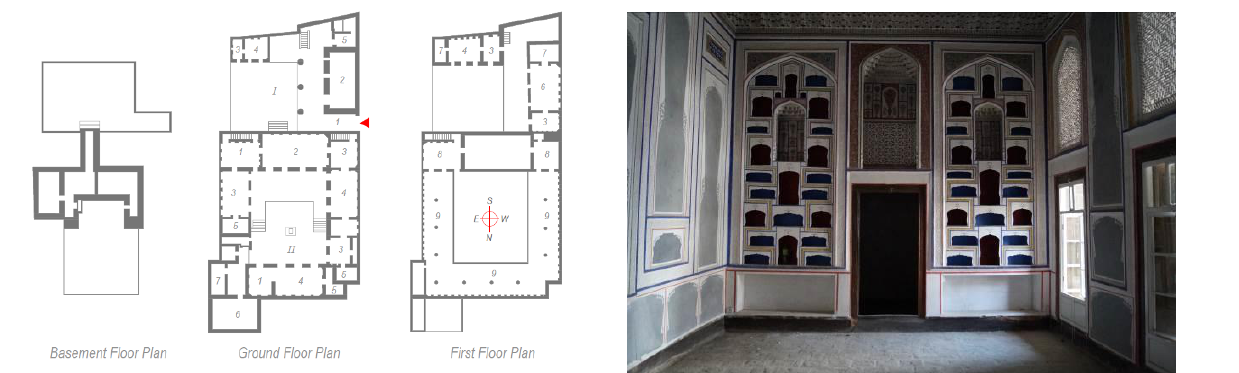
Figure 4. Mekhmonkhona in Bukhara. © UNESCO Field Survey project